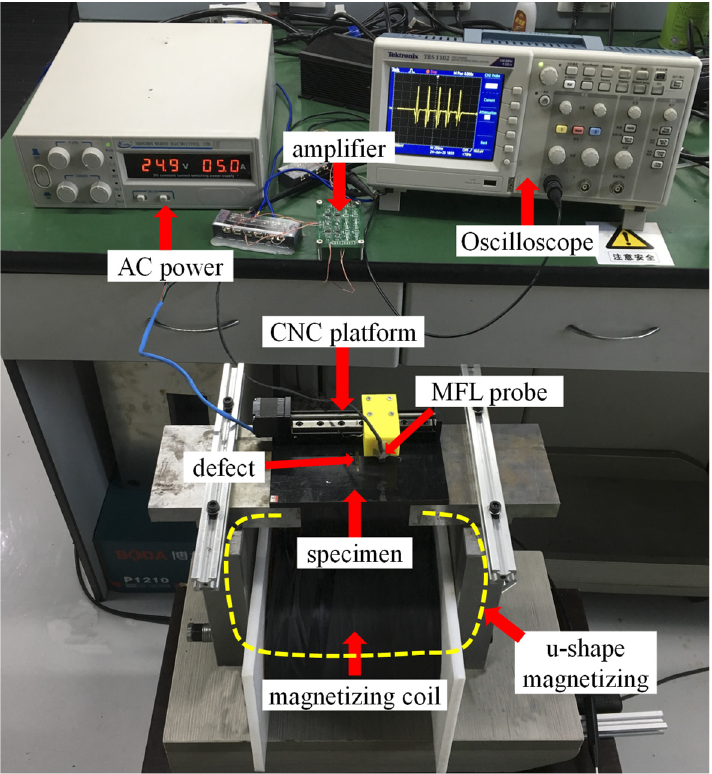
Figure 11. Experimental platform.